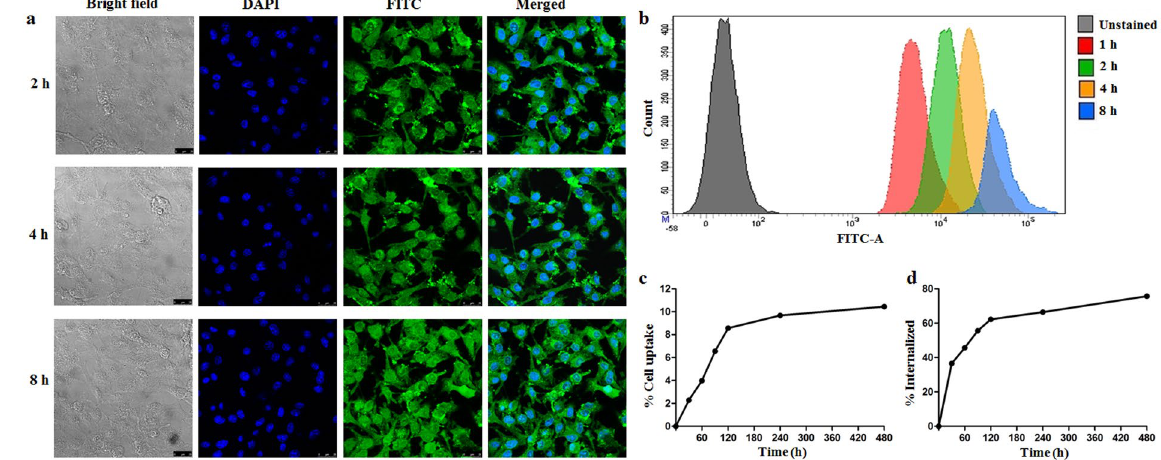
Figure 3. Fluorescence microscope images showing ( a ) time dependent uptake of FITC labeled NPs, cell nuclei are stained in blue while green dots represent fluorescently labeled NPs, ( b ) flow cytometric distribution of FITC labeled NPs at different time points. ( c ) In vitro cell binding and internalization of 99m Tc labeled GAR-NPs in B16F10 melanoma cells at different time